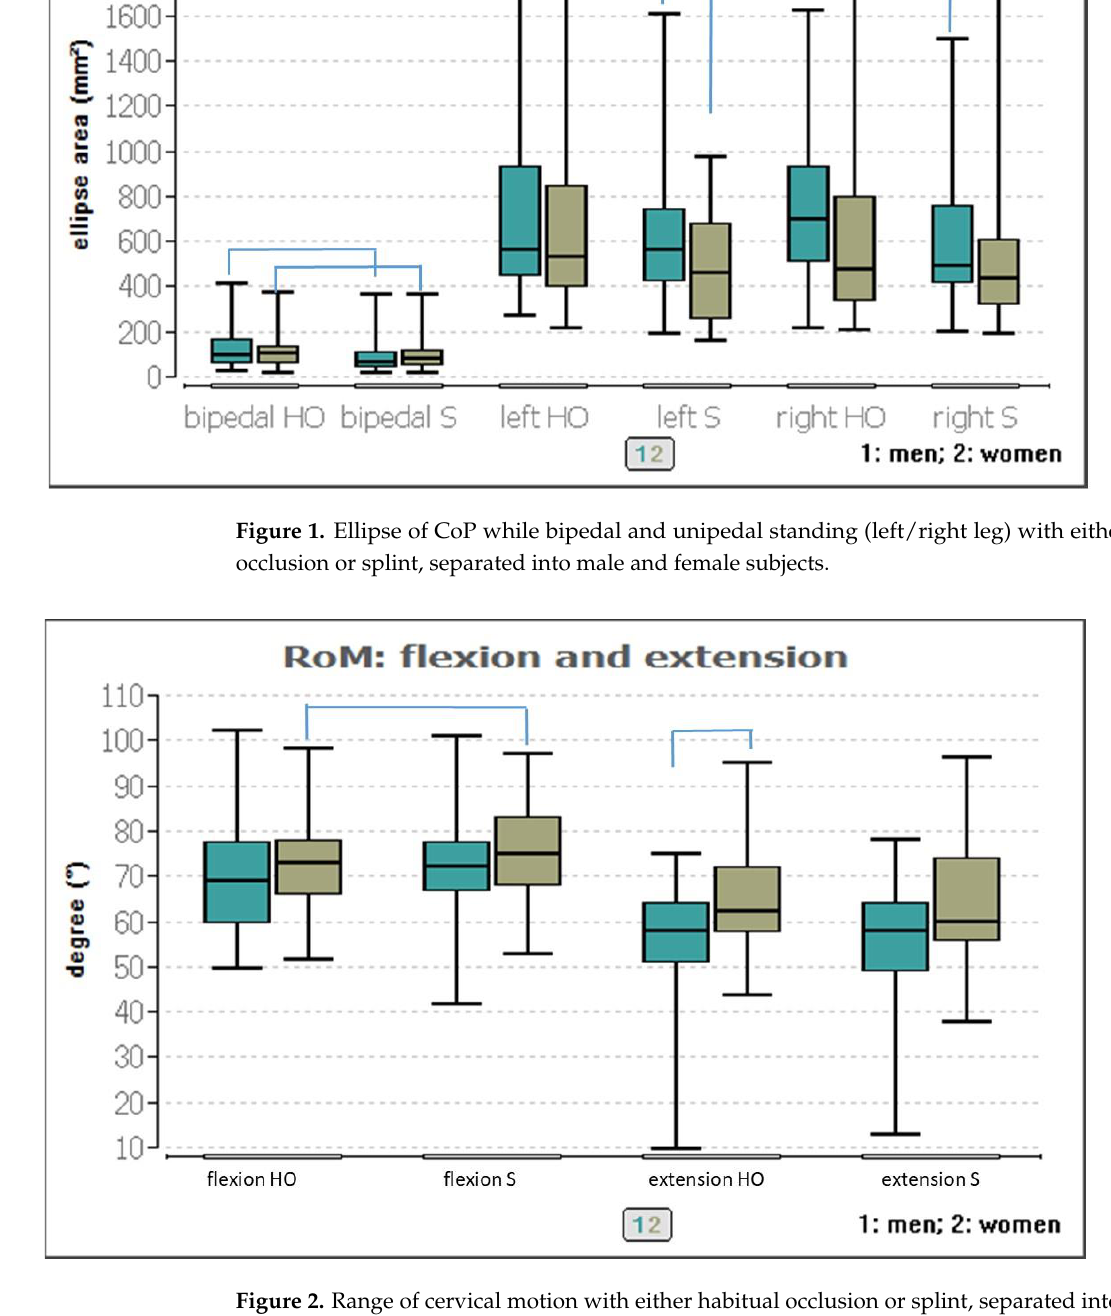
Figure 3. Center of pressure length with either habitual occlusion or splint, separated into male and female subjects. 3.2. Condition Comparison Per Sex Both conditions (HO and S) were compared within one sex (Table 2). Men : While the ellipse areas when in the bipedal stance and unipedal right-legged stance ( p ≤ 0.01 and p ≤ 0.001, respectively, Figure 1) showed significant reductions when wearing the splint, the ellipse areas while standing on the left leg ( p ≤ 0.04) showed a sig- nificant increase. The reduction of the sway area was much stronger for the right unipedal stance (approximately 202 mm 2 ) than for the bipedal stance (approximately 31 mm 2 ). In